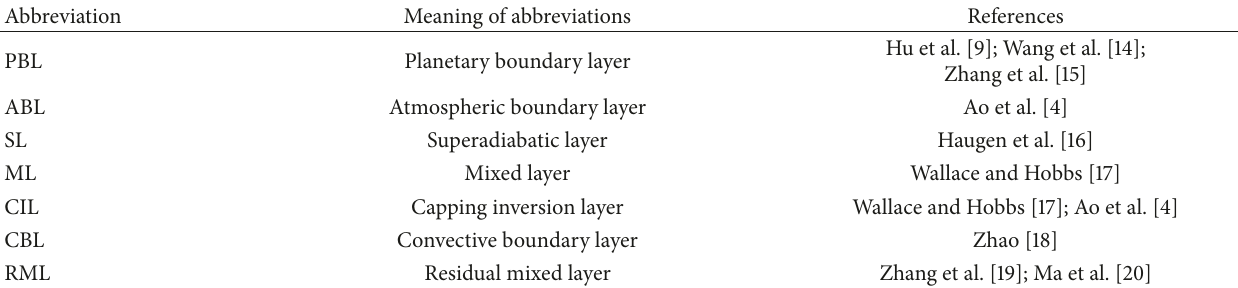
Table 1: List of studying on the relationship between air pollution and boundary layer in recent